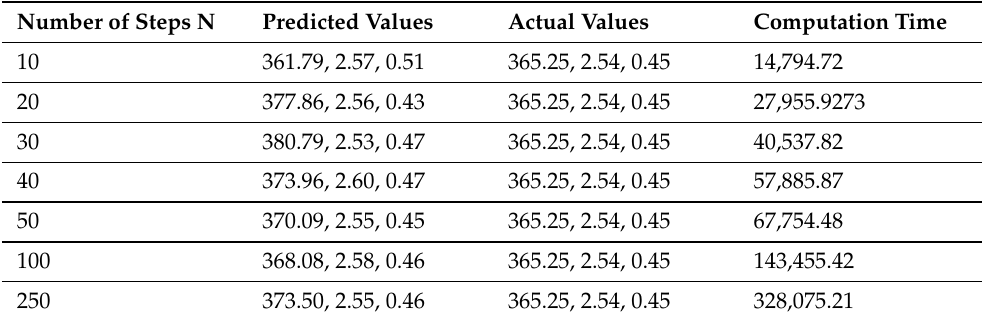
Table 13. Evaluation of similarity-based conversion approach and effect of the experiment number N, with 250 samples (k = 250) per experiment.